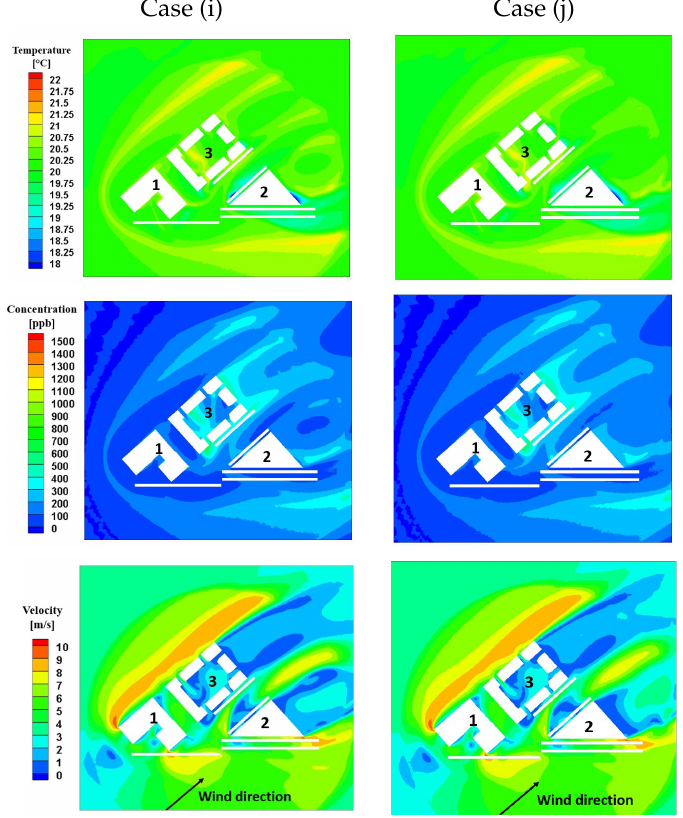
Figure 13. Contours of temperature, pollution and velocity at the pedestrian level (2 m), bottom heating: 10 ◦ C, cooling intensity: 250 W · m − 3 , wind speed at the inlet: 8 m/s. ( i ) first targeted combination of green walls and tree; ( j ) second targeted combination of green walls and